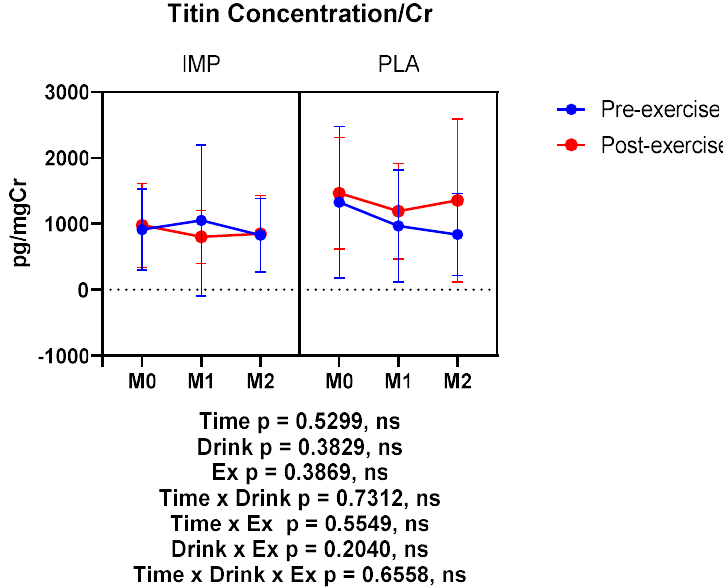
Figure 6. Urine titin concentration corrected with creatinine. The data are presented as means ± SD.